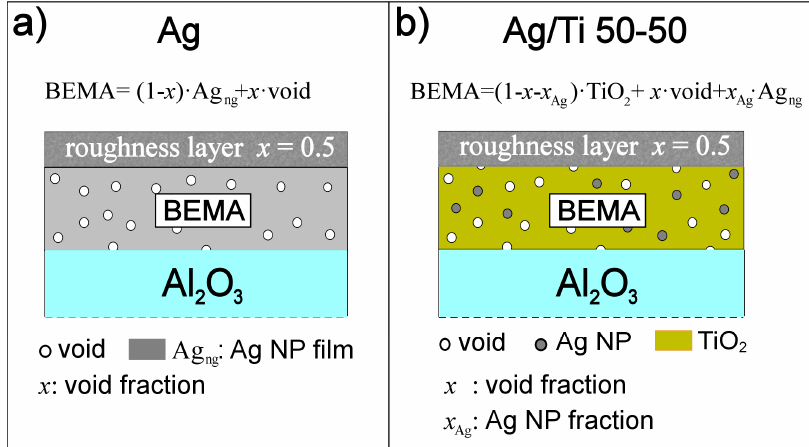
Figure 3. ( a ) layer model scheme for Ag NP film on Al 2 O 3 substrate. The porosity of the film for both Ag and Ag/Ti 50-50 films is considered through the void factor ( x ) of the Bruggeman EMA layer (BEMA). Nano-granular Ag (Ag ng ) is the host material; ( b ) layer model scheme for Ag NP/TiO 2 (Ag/Ti 50-50) film on Al 2 O 3 substrate. Amorphous TiO 2 host material encapsulates a fraction of separated Ag NPs ( x Ag ) and voids ( x ). Surface roughness and possible gradients in the film void factor are considered through a roughness layer with fixed void factor x = 0.5.